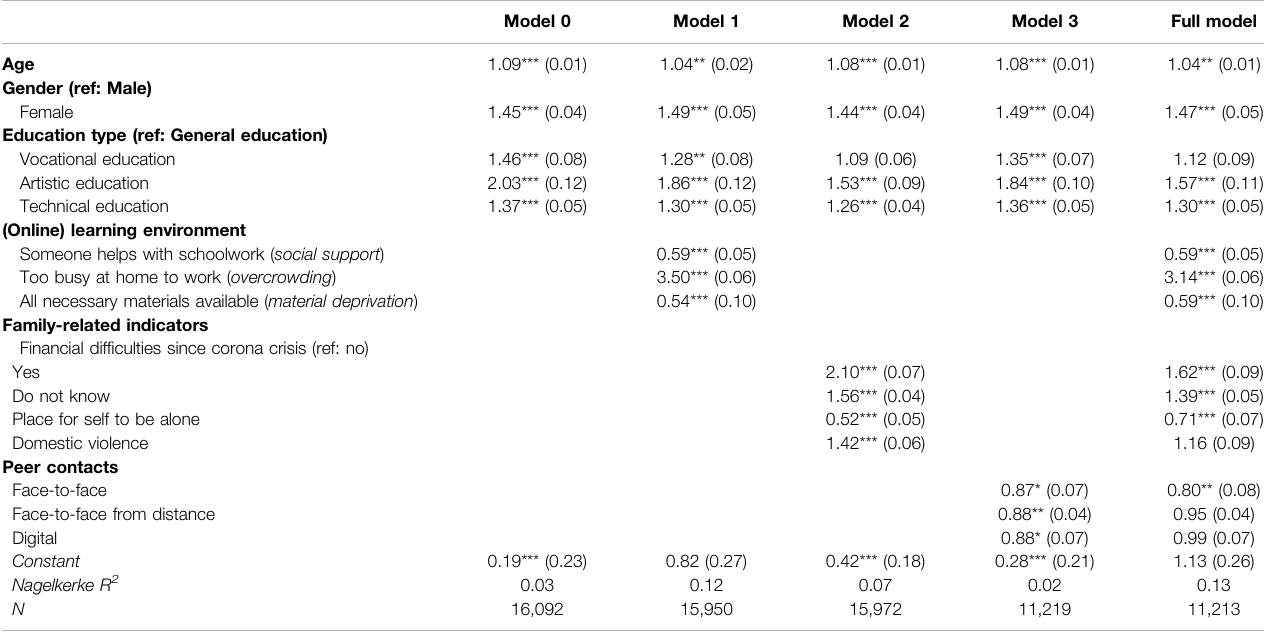
TABLE 4 | Binomial logistic regressions with increased stress due to schoolwork as outcome variable, and odds ratios of predictors.